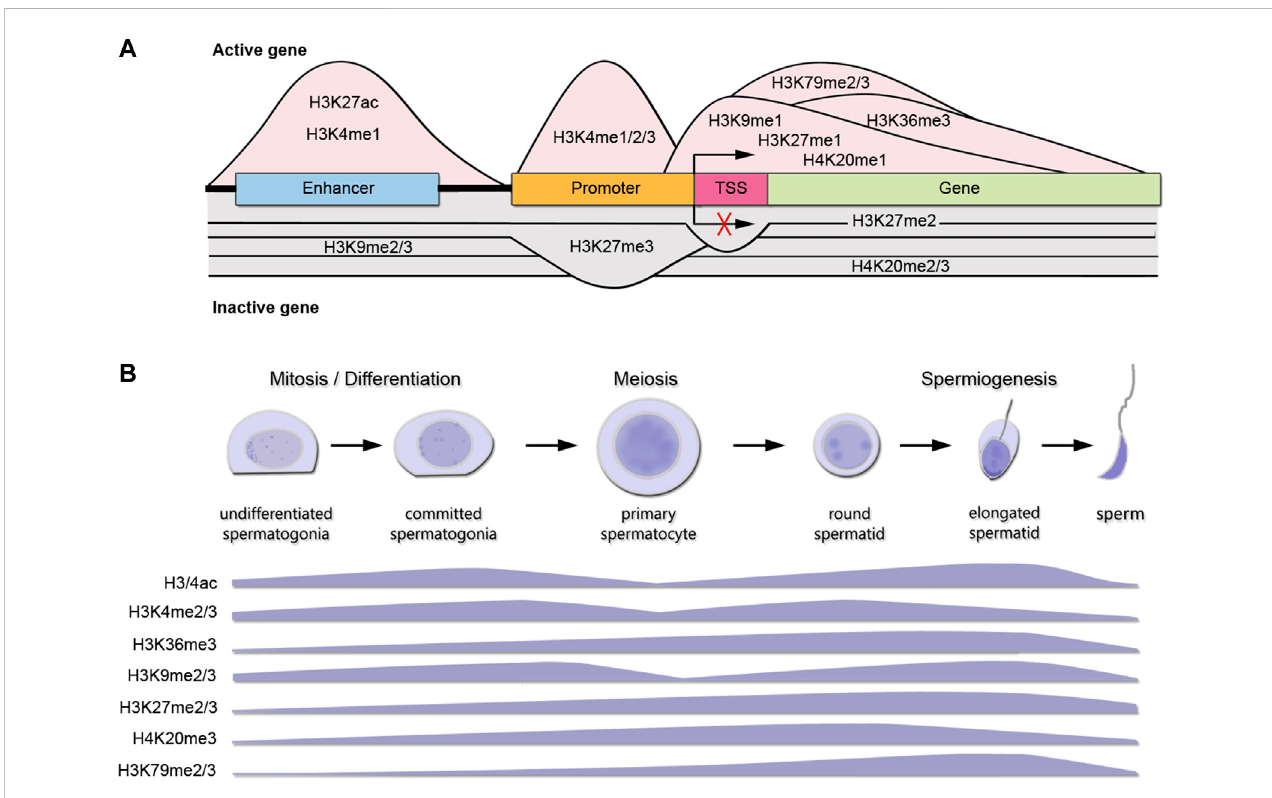
FIGURE 1 Canonical histone K marks distribution during spermatogenesis. (A) Histone K methylation PTMs distribution at DNA elements and functional roles in gene expression for an active gene (pink shading) or inactive gene (gray shading). TSS: transcription start site. Only K modi fi cations with suf fi cient and consensual information about distribution across genes are shown. (B) Levels of main histone K PTMs involved in chromatin remodeling during spermatogenesis. The data presented is summarized from the following references: Song et al., 2011 (immunohistochemistry H3ac, H3K4me3, H3K27me3);Godmannetal.,2007(immunohistochemistryandwesternblotH3K4me1/2/3);Zuoetal.,2018(immuno fl uorescenceH3K36me3);Luenseetal., 2016 (Tandem mass spectrometry H3/4ac; H3K36me3, H3K9me2, H3K27me2/3, H4K20me3, H3K79me2); Wang et al., 2021 (immuno fl uorescence H3K20me3). SGund: spermatogonia Kit-, SGdiff: spermatogonia Kit+, PreL: pre-leptotene spermatocytes, LZ: leptotene/zygotene spermatocytes, PD: pachytene/diplotene spermatocytes, RStid: round